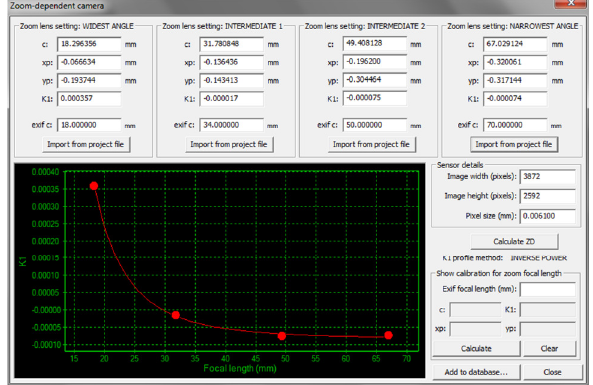
Figure 3. Z-D calibration dialog in iWitnessPRO.